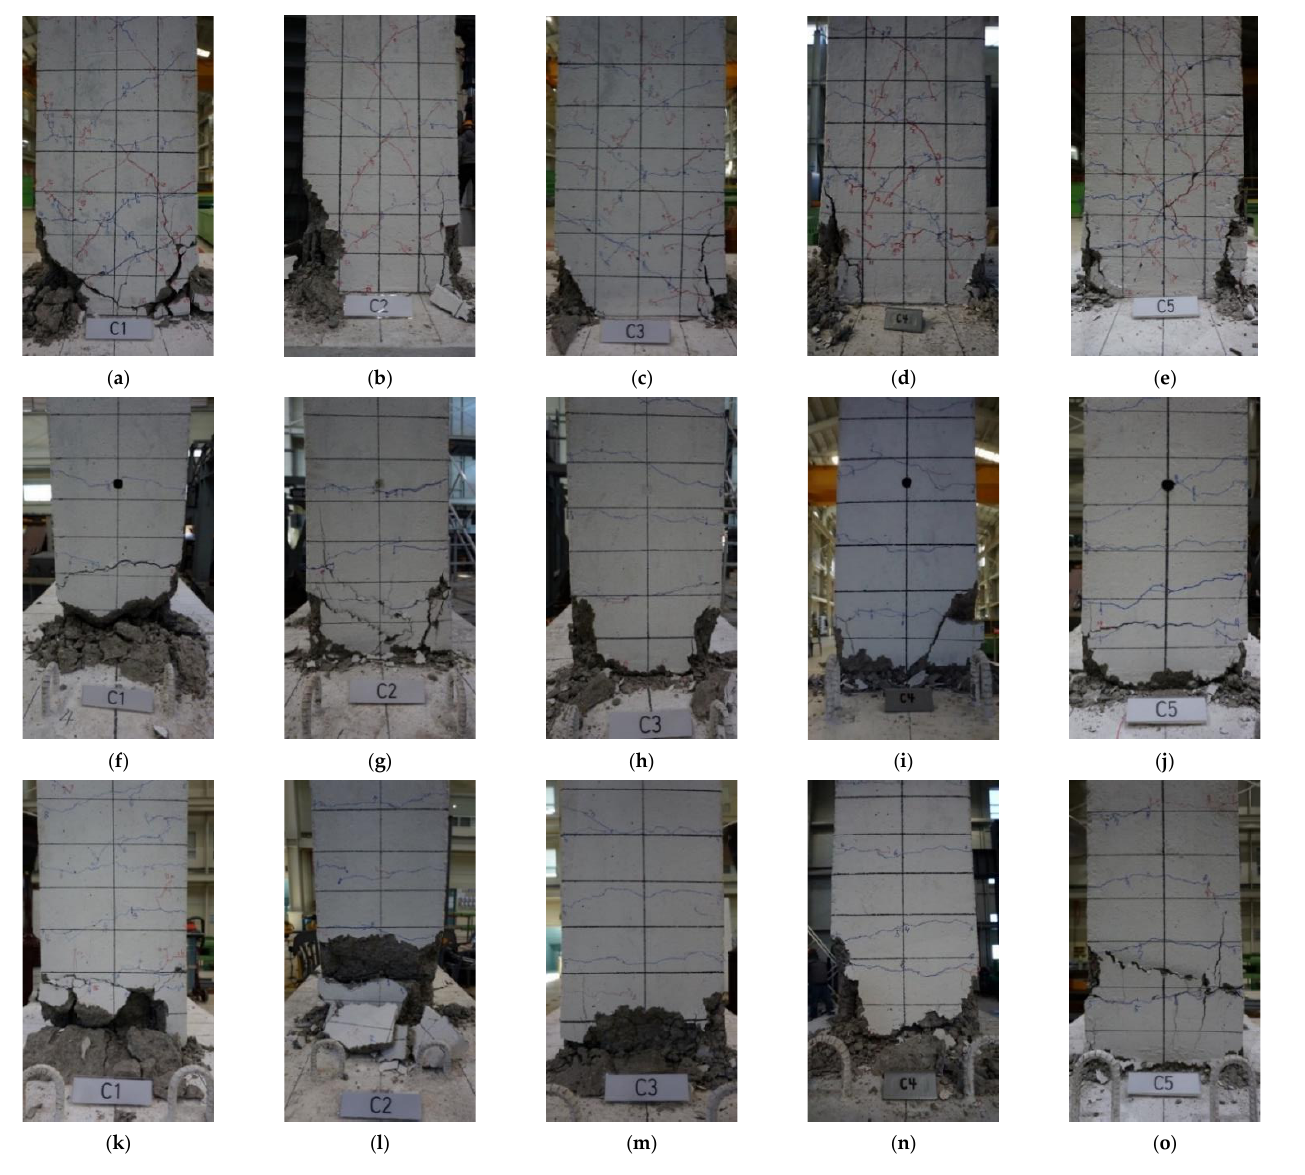
Figure 6. Final damage state observed on each side of the column at the end of the experiment: ( a ) C1, front; ( b ) C2, front; ( c ) C3, front; ( d ) C4, front; ( e ) C5, front; ( f ) C1, right; ( g ) C2, right; ( h ) C3, right; ( i ) C4, right; ( j ) C5, right; ( k ) C1, left; ( l ) C2, left; ( m ) C3, left; ( n ) C4, left; ( o ) C5, left.